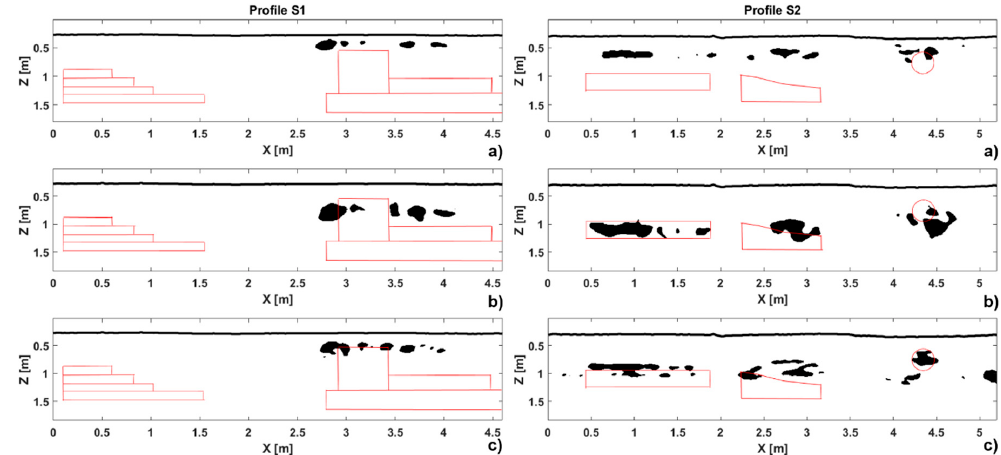
Figure 12. Binary images of the tomographic images with superimposed in red the boundaries of the true targets. panels ( a – c ) show the binary images of the tomographic images obtained with relative permittivity of the freshwater ((cid:2013) (cid:3050) ) , the wet sand ((cid:2013) (cid:3050)(cid:3046) ) , and the equivalent one (cid:3435)(cid:2013) (cid:3050)(cid:3046)(cid:3032)(cid:3044) (cid:3439) , respectively As a consequence, in order to estimate depth and extension along X -axis of the paved road, we have also elaborated only the portion of the radargram related to it, i.e., the portion of the radargram from (cid:1876) = 0 m to (cid:1876) = 2.10 m (see Figure 9a). In addition, the time gating was applied by forcing to zero the portion of the radargram external to the range from (cid:1872) (cid:3040)(cid:3036)(cid:3041) = 33 ns to (cid:1872) (cid:3040)(cid:3028)(cid:3051) = 45 ns, in order to emphasize the presence of the target and remove the replica due to the freshwater-wet sand interface. The filtered data concerning the paved road is shown in Figure 13.